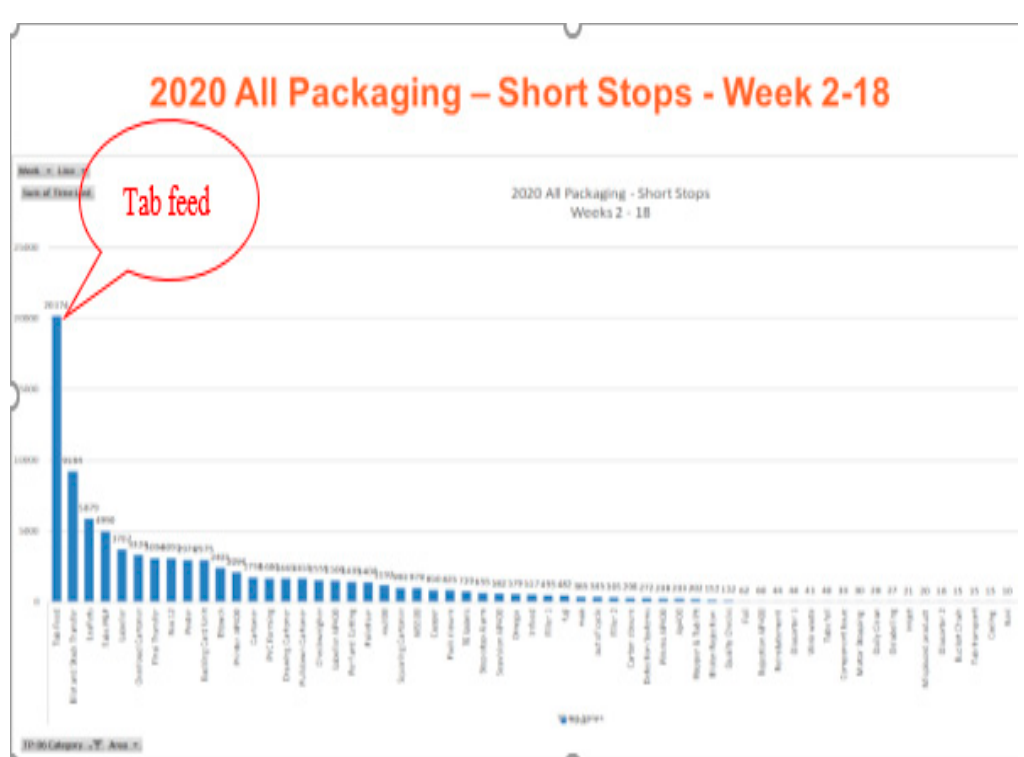
Figure 4. Breakdown of total downtime related to packaging Short Stops across nine packaging lines over a 16-week period.